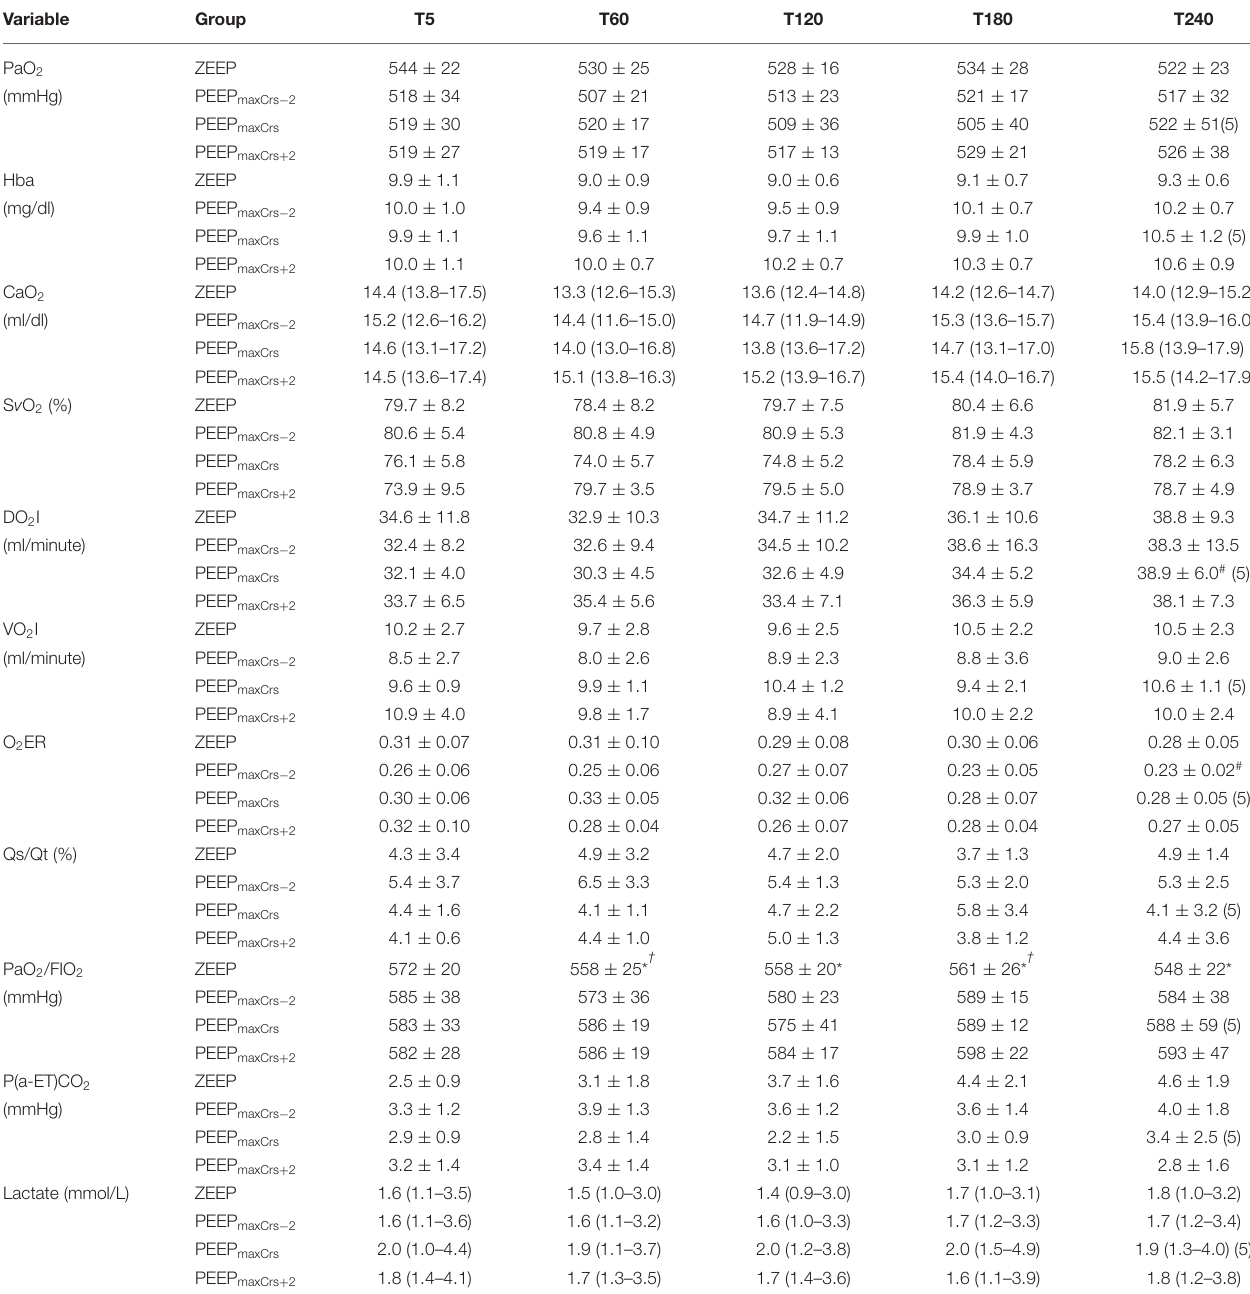
TABLE 4 | Pulmonary gas exchange, arterial hemoglobin (Hba) and lactate concentrations, and oxygenation variables in six (unless indicated within parenthesis) isoflurane-anesthetized cats mechanically ventilated for 3h with a tidal volume of 10 ml/kg and four end-expiratory pressure treatments: zero end-expiratory